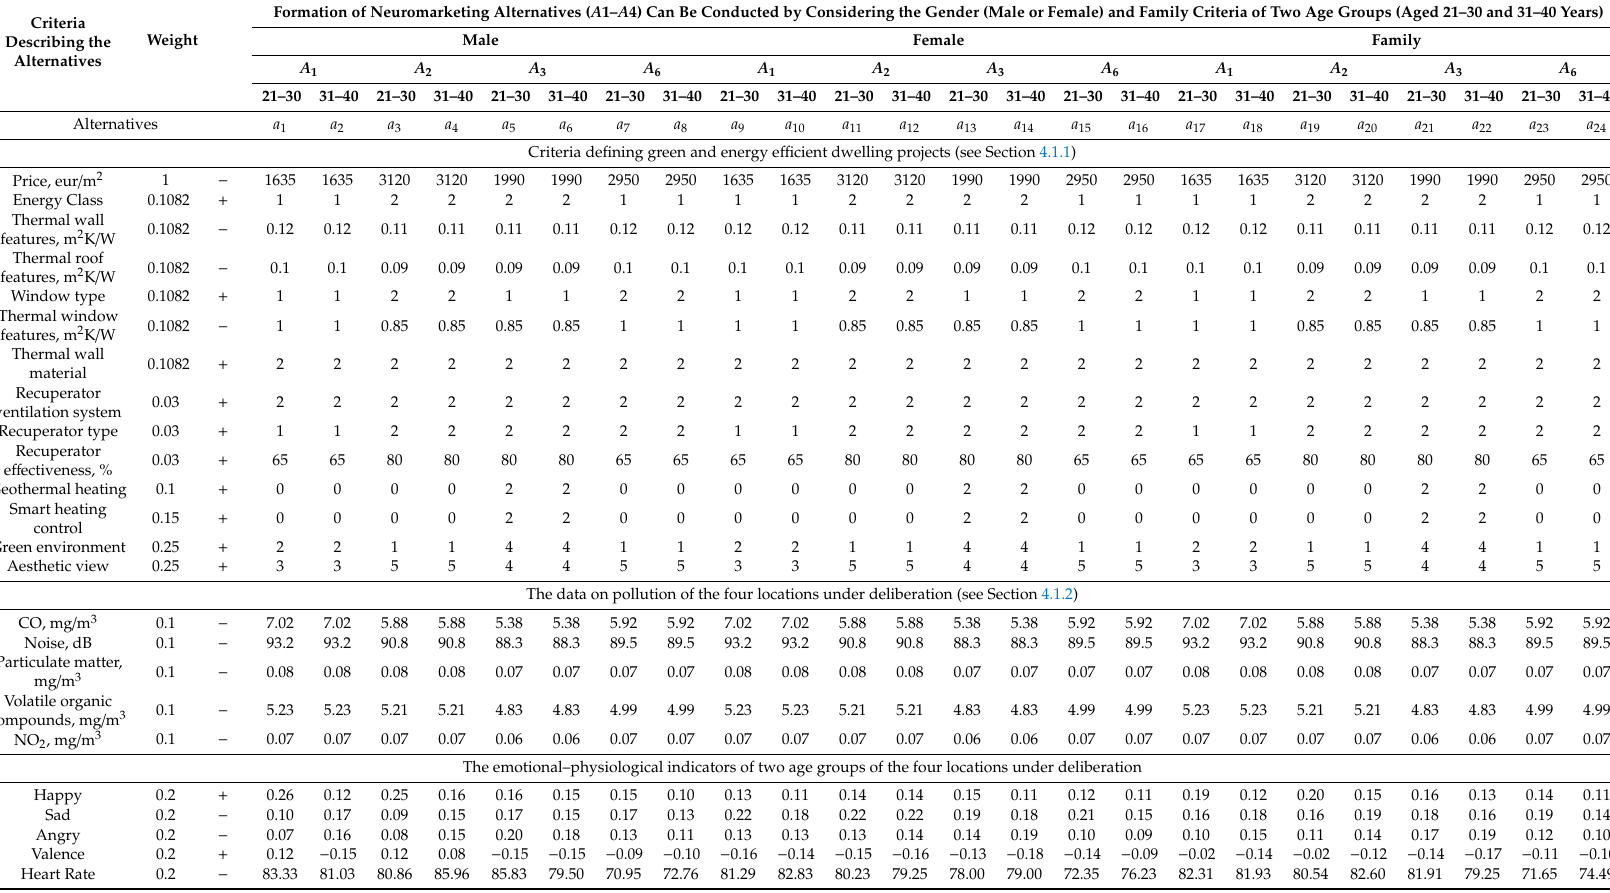
Table 3. Neuro decision matrix of 24 Vilnius City market segments for green and energy e ffi cient residential projects. Formation of Neuromarketing Alternatives ( A 1– A 4) Can Be Conducted by Considering the Gender (Male or Female) and Family Criteria of Two Age Groups (Aged 21–30 and 31–40 Years) Criteria Weight Describing the Alternatives